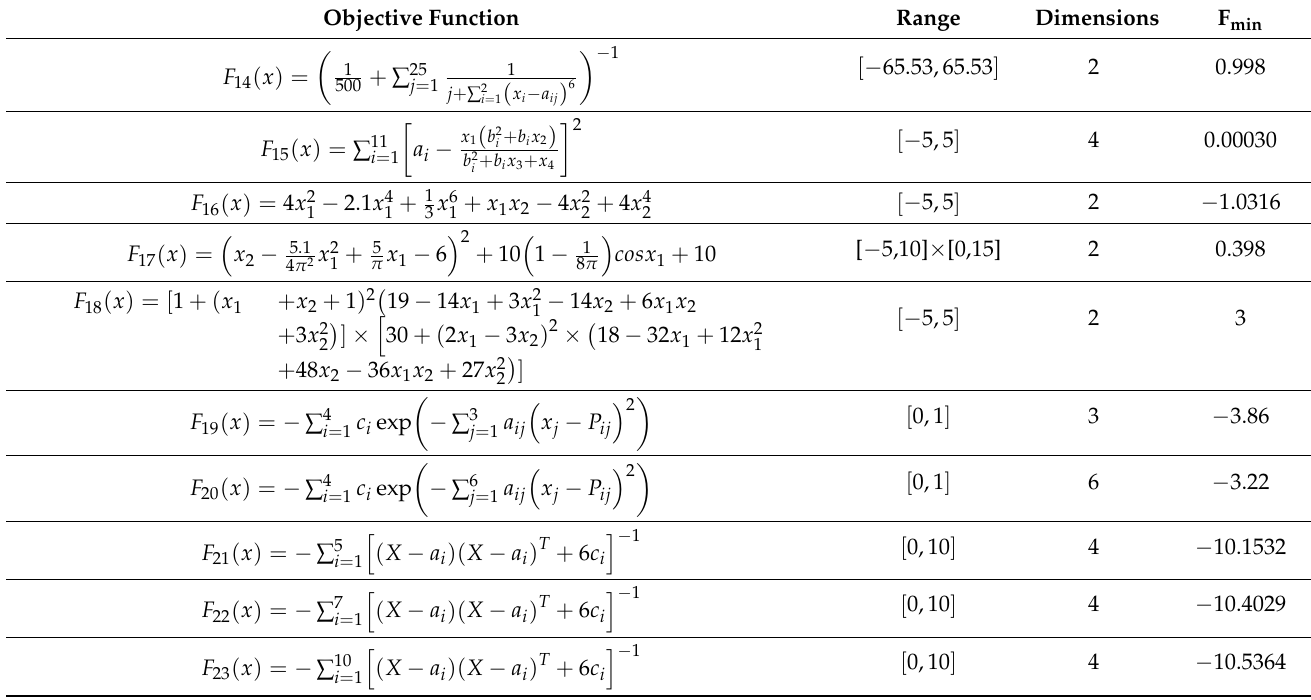
Table A3. Fixed-dimensional multimodal test